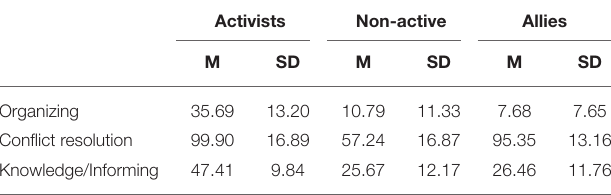
individual campuses. The proportion of Activist students ranged from 17 to 40% of respondents at our 24 MSI